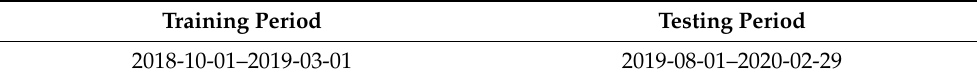
Table 15. Training and testing periods for Automation Manager